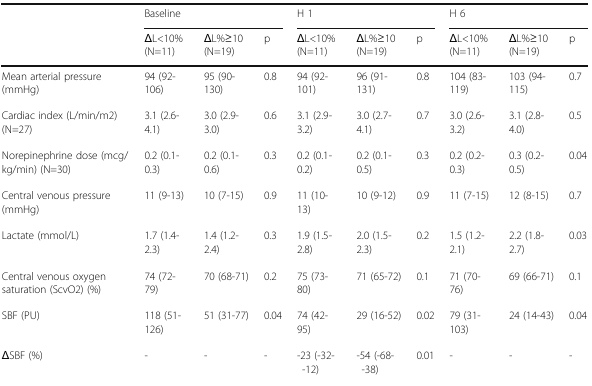
Table 1 (abstract 0323). Hemodynamic and skin blood flow variables during the study